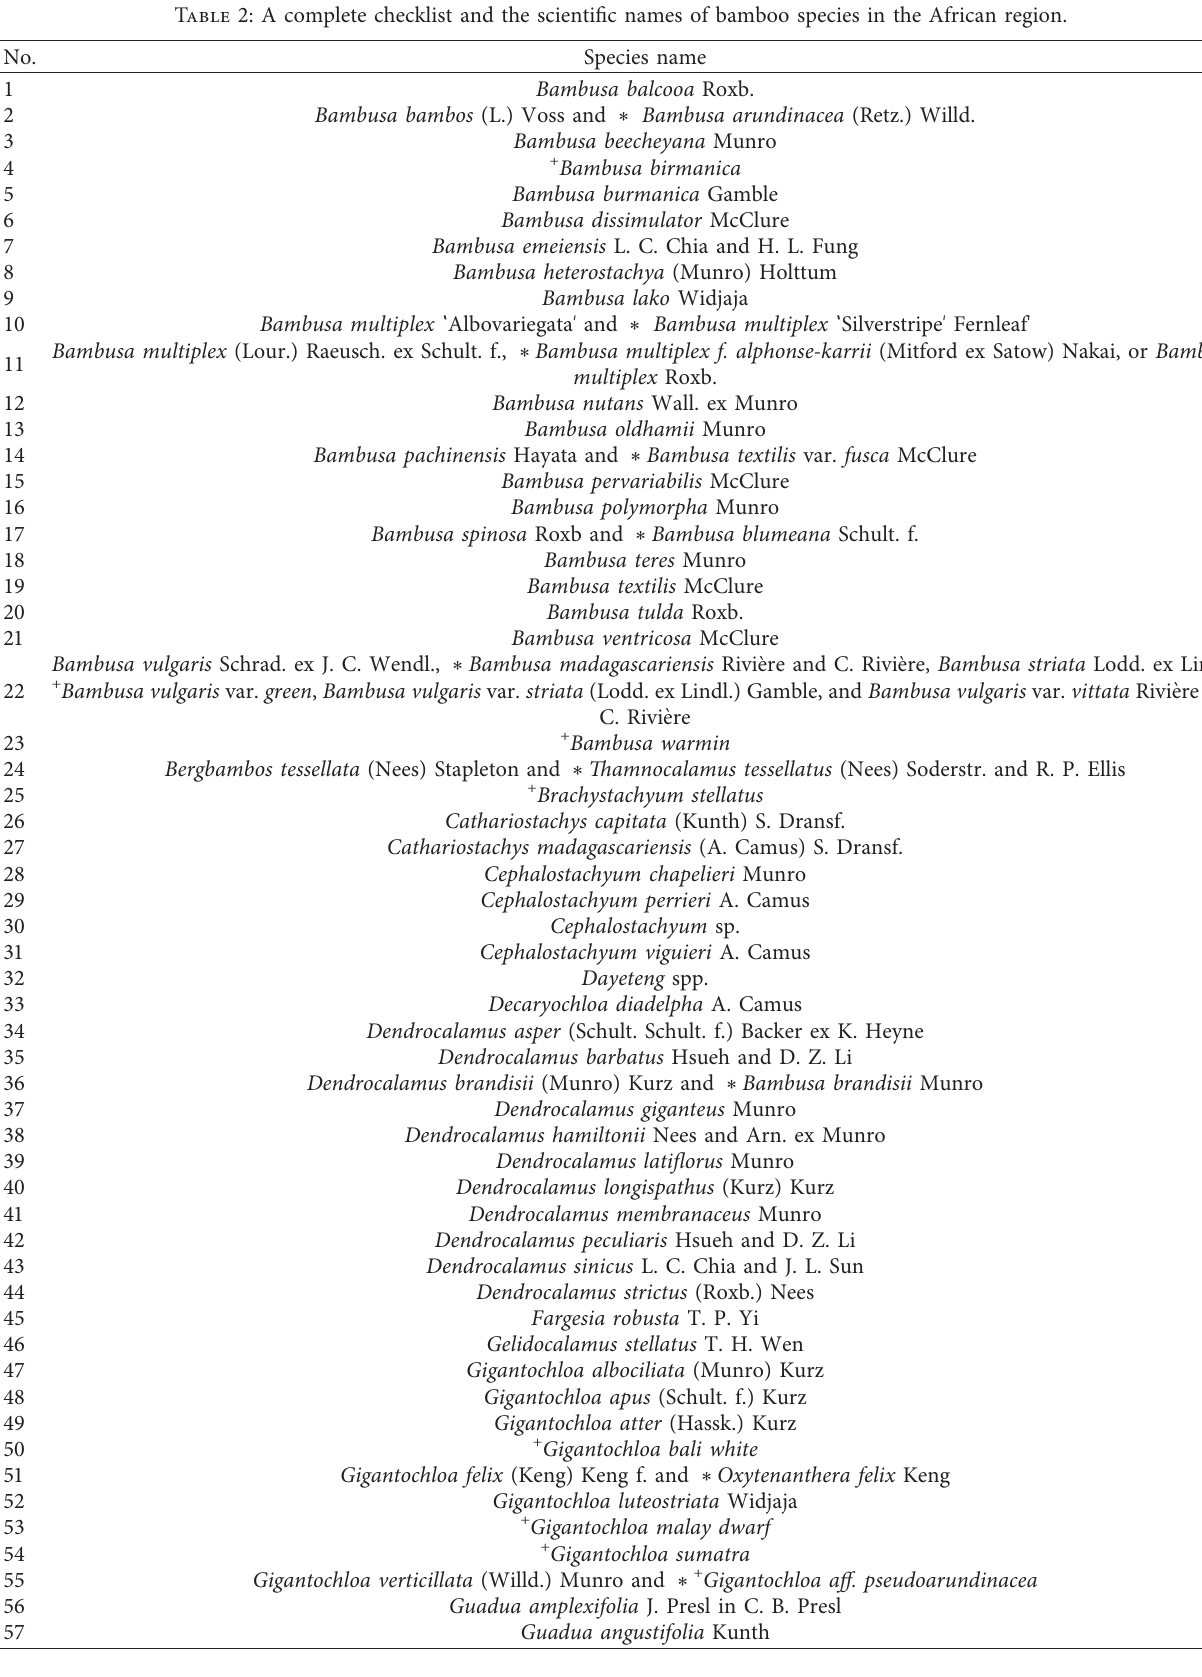
Table 2: A complete checklist and the scientific names of bamboo species in the African region.